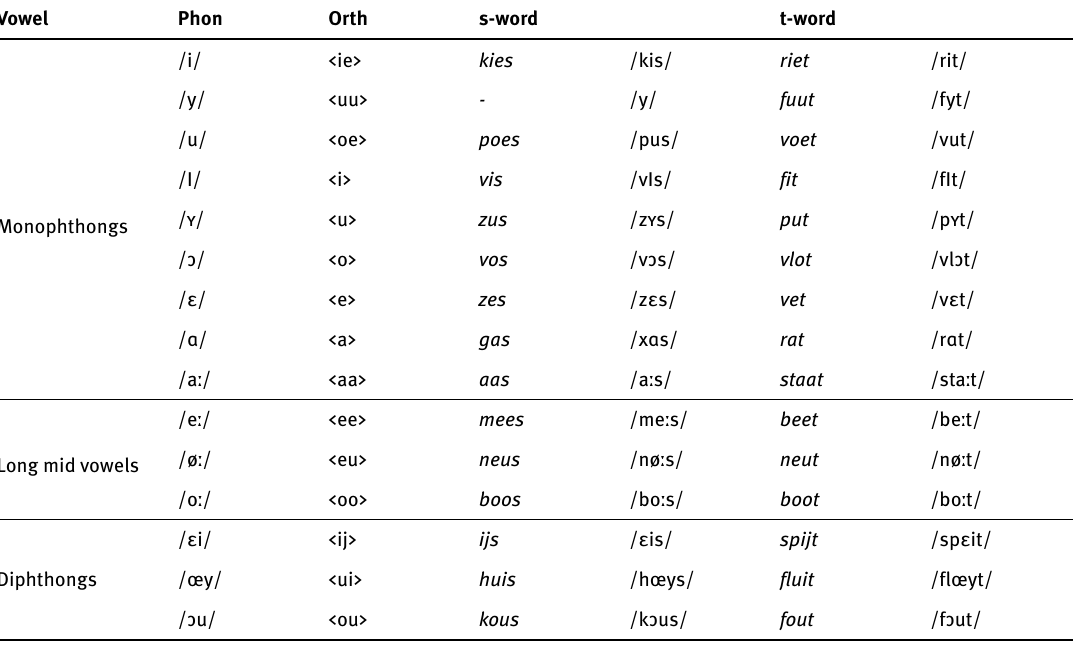
Table 3. Selected –s and –t words as speech stimuli (Van der Harst 2011); Phon = phonological representation (in IPA), Orth = orthographic